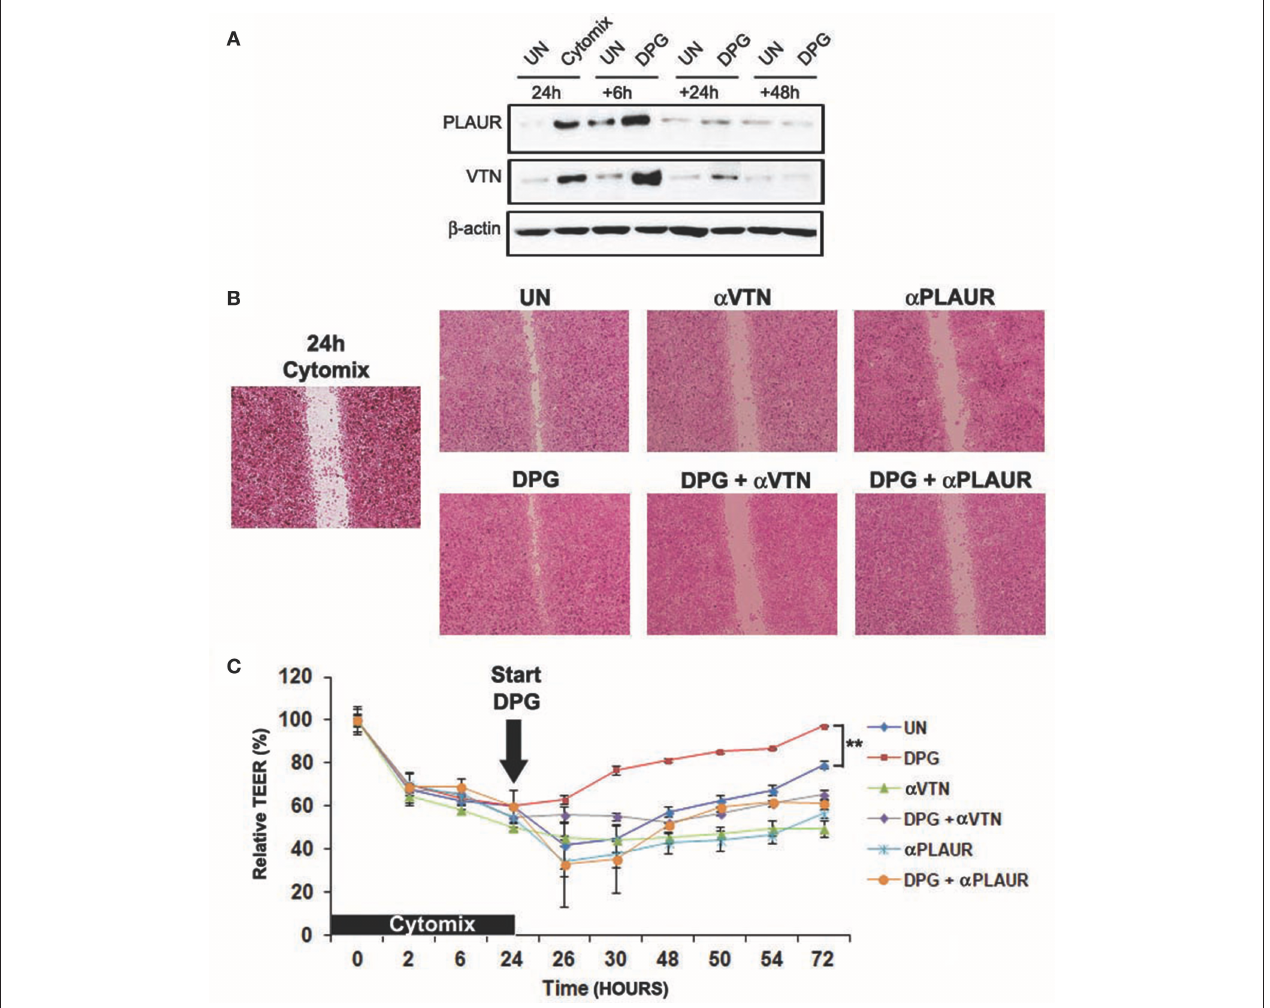
FIGURE 6 | Proteins VTN and PLAUR are fundamental to achieve mucosal healing during DPG treatment in vitro . HT29 cells were pre-treated with cytomix for 24h and then were exposed to DPG for 6, 24, and 48h. (A) VTN and PLAUR expression was analyzed by western blot. In the same experimental condition as above HT29 or Caco2 were treated with DPG, with an anti-Plaur antibody or with the inhibitor of VTN, alone or in combination with DPG and (B) wound healing and (C) epithelial barrier integrity were evaluated by scratch test (HT29) and TEER (Caco2), respectively. The experiments were repeated in triplicate. Statistical analysis: Mann- Whitney test ** p < 0.01. UN, untreated cells; DPG, dipotassium